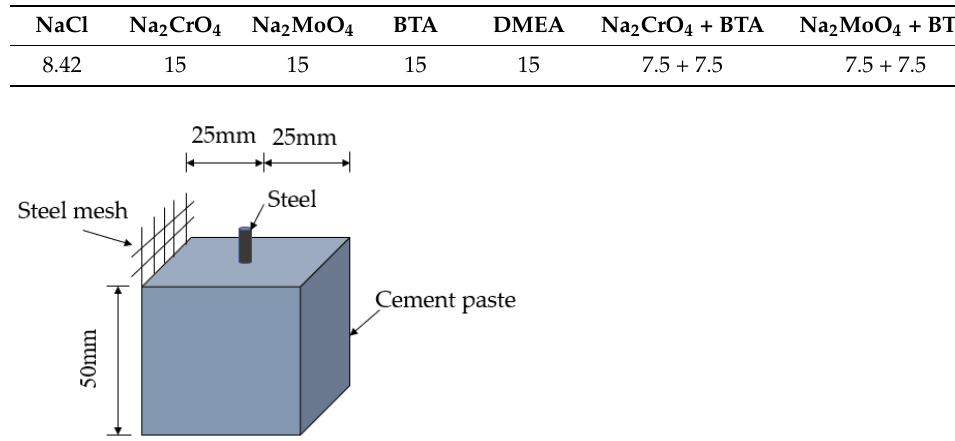
Table 3. The content of the rust inhibitor and NaCl g/L.